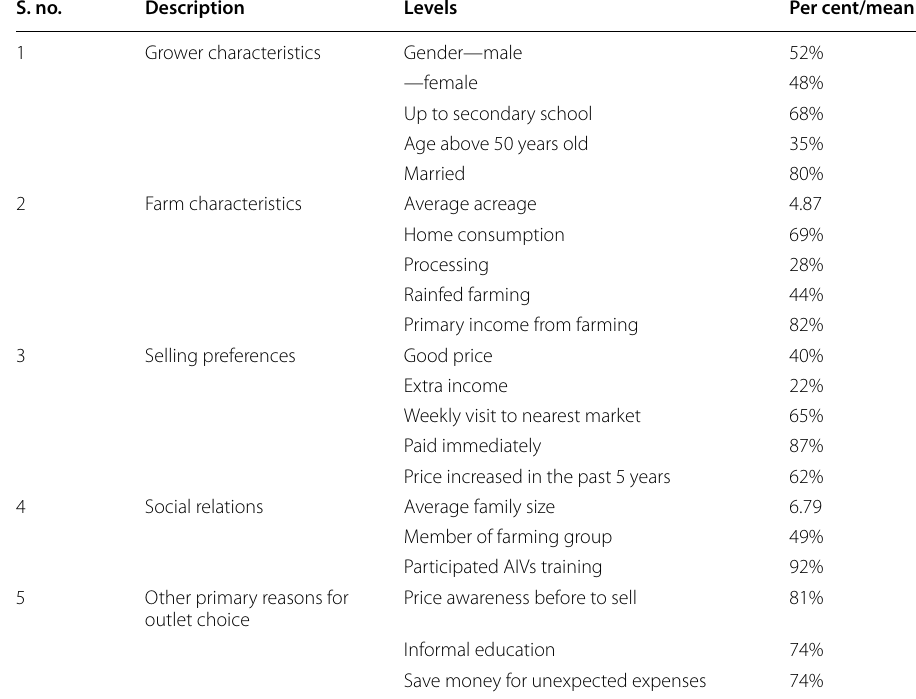
Table 1 Description of explanatory variables S.